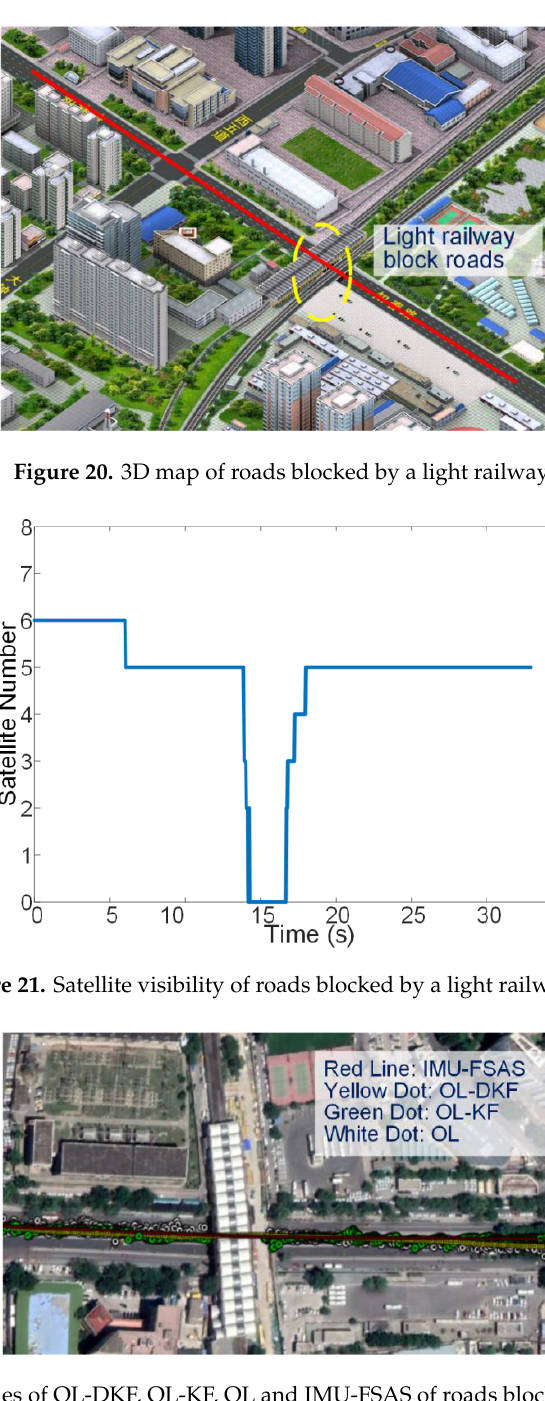
Figure 22. Trajectories of OL-DKF, OL-KF, OL and IMU-FSAS of roads blocked by a light railway.